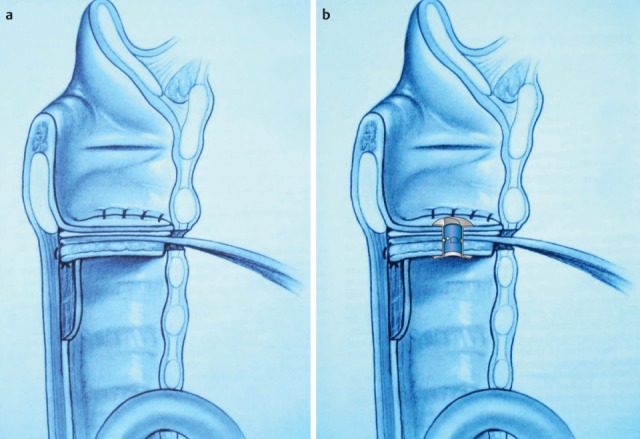
a – the donor site of the cranially pedicled mucosal flap is covered by the skin-platysma-fascia graft; b – two months after healing, a shunt valve is inserted into the tracheal closure after puncture; speaking is possible with the patient's own, individual voice.